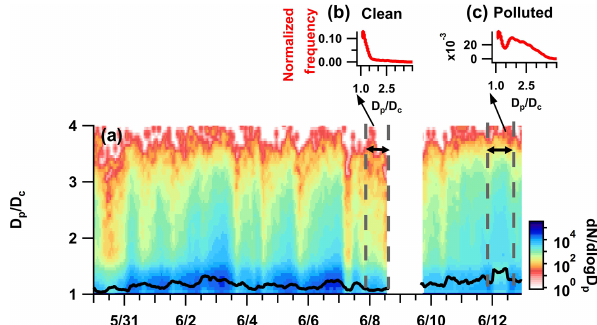
Figure 7. (a) Temporal variation in D p /D c , with D c = 180nm; the image plot denotes the frequency (d N / dlog D p ) of rBC-containing particles with varied D p /D c values. The black line denotes the aver- age D p /D c for each hour. (b) The normalized frequency of D p /D c for the clean period before the tandem experiment. (c) The normal- ized frequency of D p /D c for the polluted period.